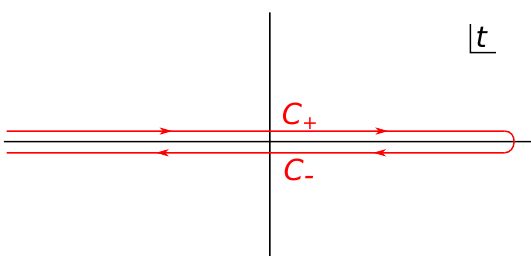
Figure 1 . The Schwinger-Keldysh contour in the complex time